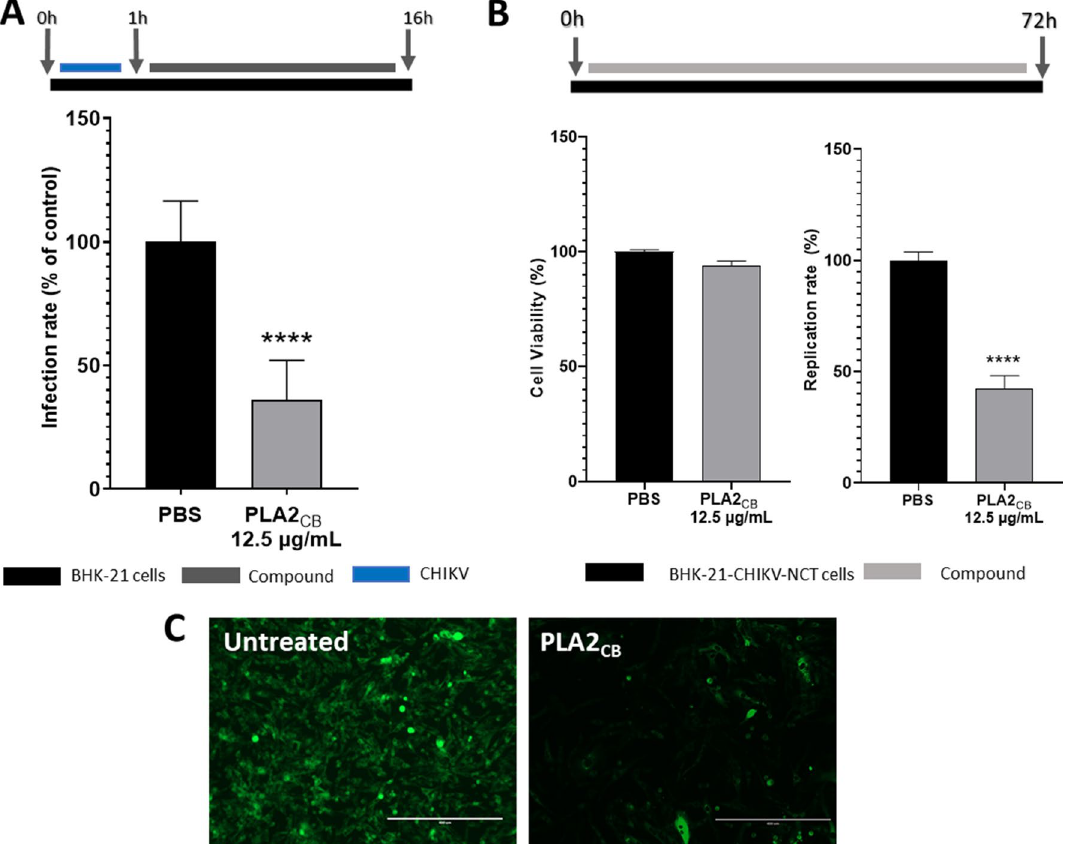
Figure 4. PLA2 CB inhibits post-entry stage of CHIKV. ( A ) BHK-21 cells were infected with CHIKV- nanoluc (MOI 0.1) for 1 h, washed to remove unbound virus and added of medium containing PLA2 CB at 12.5 μg/mL for 16 h. Nanoluciferase levels were measured to access CHIKV- nanoluc replication rates. ( B ) BHK-CHIKV- NCT cells were seed 24 h prior treatment and treated with PLA2 CB at 12,5 μg/mL for 72 h. Renilla luciferease activity and cellular viability measured. ( C ) Fluorescence of untreated control and PLA2 CB treatment in BHK- CHIKV-NCT, observed in fluorescence microscopy using 20 × lens (scale bar 400 µm), in GFP filter. Schematic representation of each assay as indicated by BHK-21 cells or BHK-CHIKV-NCT (black bars), PLA2 CB (grey bars), and CHIKV- nanoluc (blue bars). Mean values ± SD of a minimum of three independent experiments each measured in triplicate. (****) P < 0.0001. All images were generated using GraphPad Prism 8 and GIMP 2.10.20 (www. gimp. org).